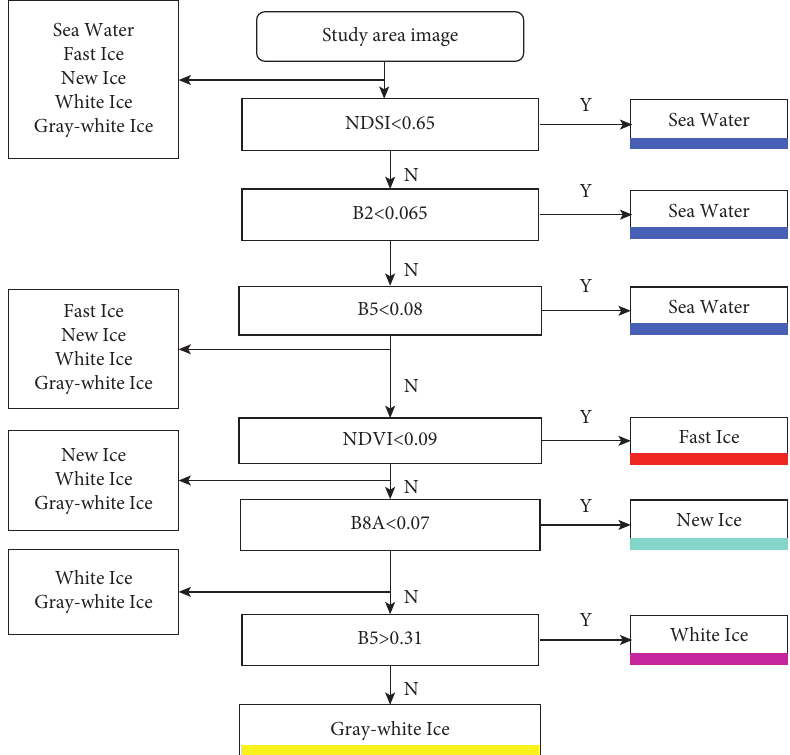
Figure 7: A decision tree model for discriminating the sea ice types in Liaodong Bay. The boxes on the left hand side denote the surface types still included in the image before the next classification